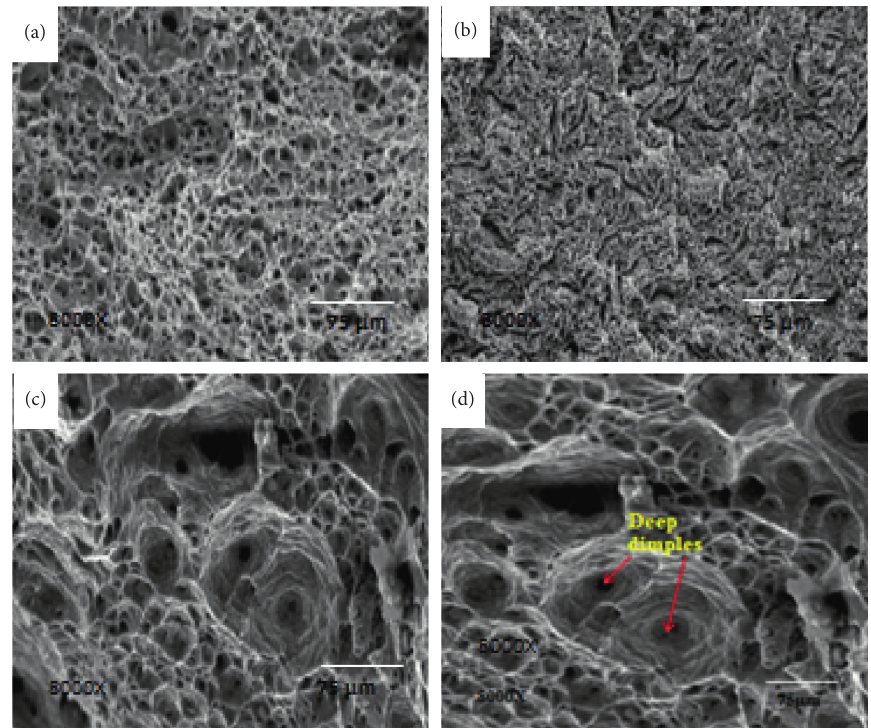
Figure 8: SEM after fracture of (a) AA6061/2% RHA at 75 μ m, (b) AA6061/4% RHA at 75 μ m, (c) AA6061/6% RHA at 75 μ m, and (d) AA6061/8% RHA at 75 μ m.